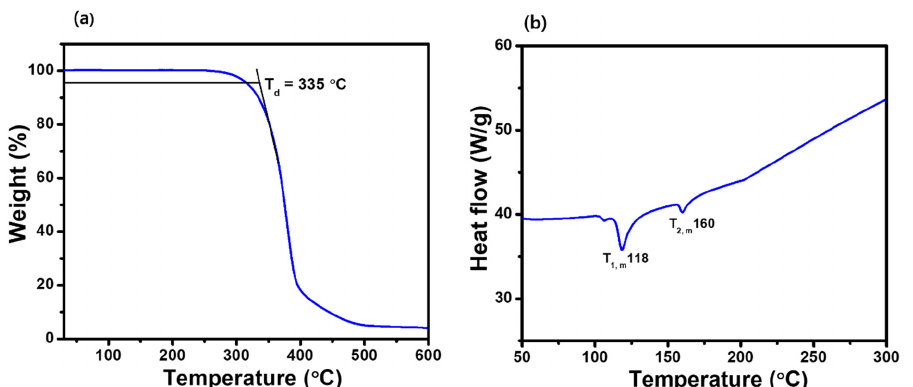
Figure 1 . ( a ) Thermogravimetric analysis (TGA) and ( b ) differential scanning calorimetry (DSC) plots of